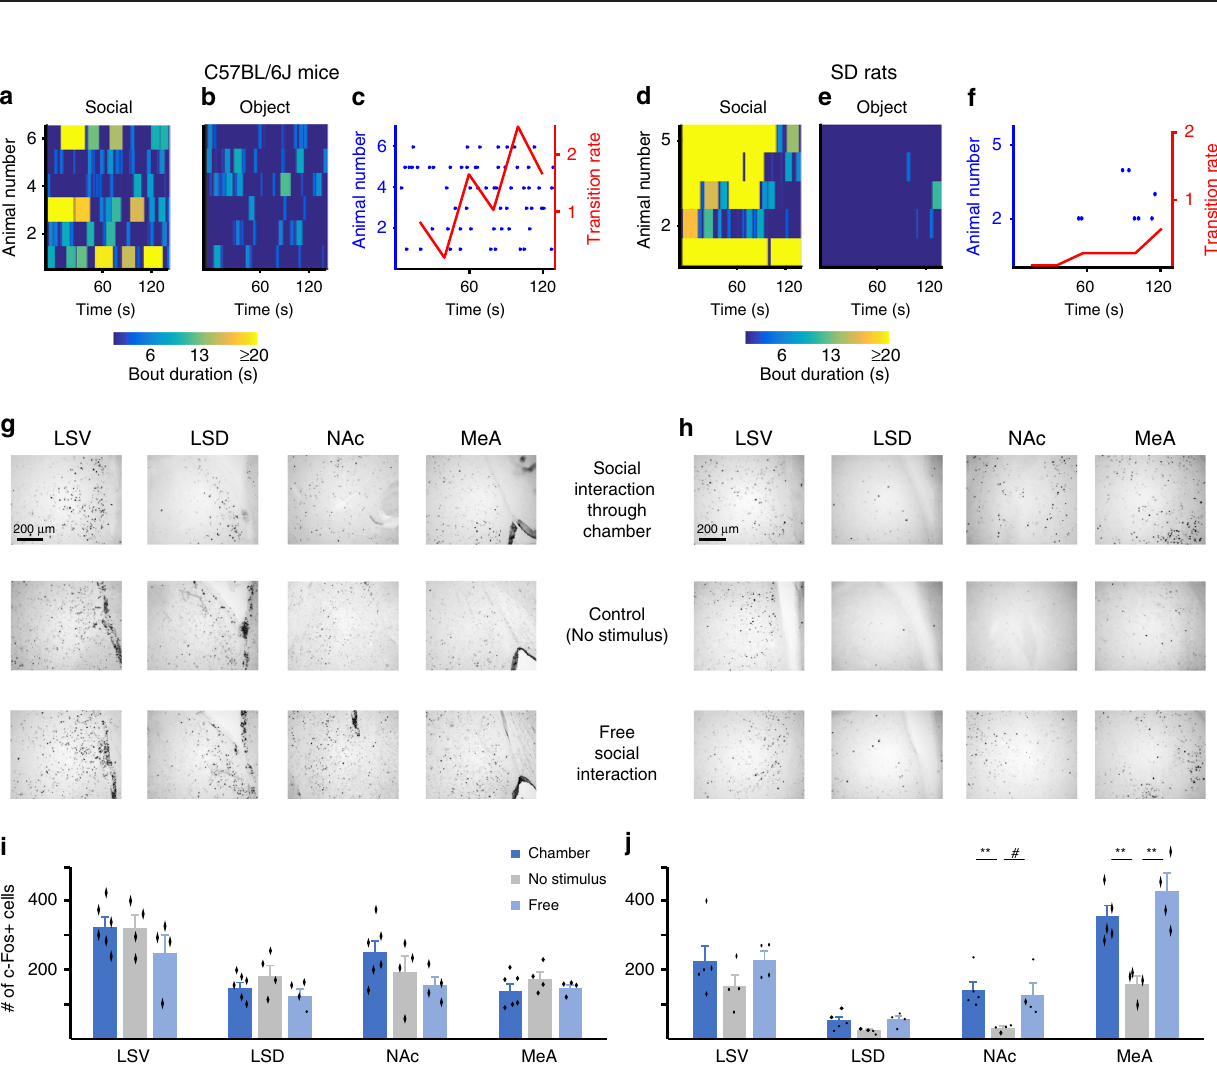
Fig. 5 Different responses of SD rat and C57BL/6J mouse subjects to movements made by social stimuli. a Array of piezoelectric sensor disks spread on the fl oor of a triangular chamber. b A scheme of the electric circuit used for acquiring data from the piezoelectric sensors during experiments. c An example of a raw-signal trace recorded during a 5-min SP test from a mouse social stimulus. The inset shows a short section in higher time resolution. d Mean number of large movements (averaged using 1-min bins) performed by mouse social stimuli ( n = 28) across the time course of the SP test. e Development of social investigation following a major stimulus movement (red trace) or without major movement (orange trace), superimposed on the mean signal of the stimulus movement (blue trace, right y -axis). Dashed line represents the peak of the mean movement. f Same as in e , for investigation of the object stimulus during the same experiments. g Mean cumulative investigation time of the social (left) or object (right) stimuli, with (red) or without (orange) social stimulus movement. h – l As in d – g , for rats ( n = 24). * p < 0.05, *** p < 0.001, post hoc two-tail t test following the main effect. All error bars represent SEM. Source data are provided as a Source Data fi le.